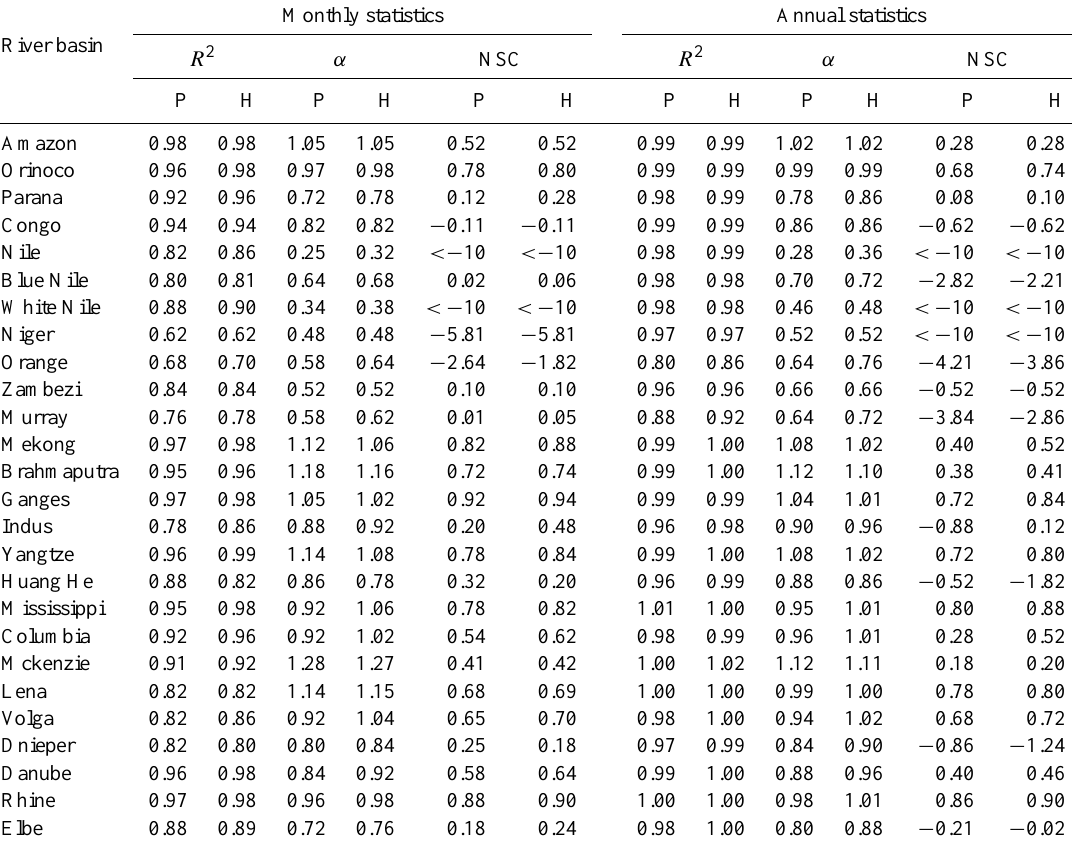
Table 5. Comparison of simulated to observed river discharge for selected major basins of the world. Simulated river discharge was derived under the pristine conditions (P; natural climate variability only) and under the human-induced change (H; human water use and reservoir operations). The results were obtained from the mean of the simulation with the ERA-Interim and MERRA climate. The observed river discharge was taken from the selected GRDC stations (http://www.bafg.de/GRDC) closest to outlets based on available records (1979-2010) for each basin. R 2 , α , and NSC denote the coefficient of determination, the slope ( x coordinate: simulated discharge; y coordinate: observed discharge), and the Nash–Sutcliffe model efficiency coefficient (Nash and Sutcliffe,